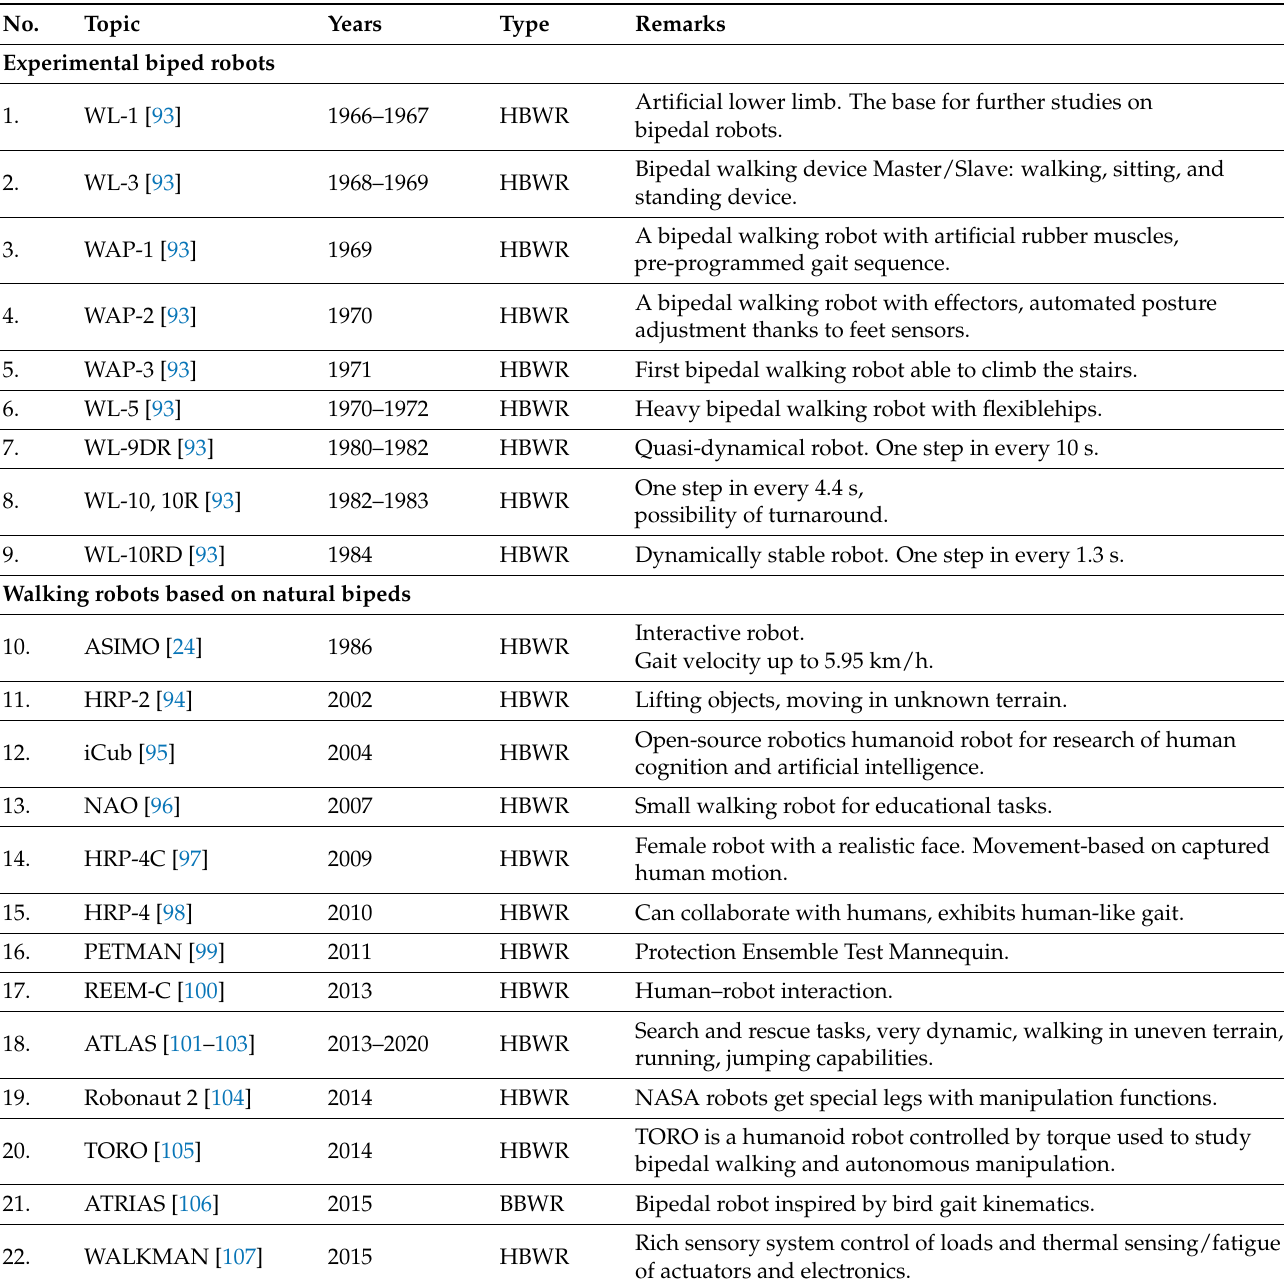
Table 1. Summary of previous bipedal walking robot